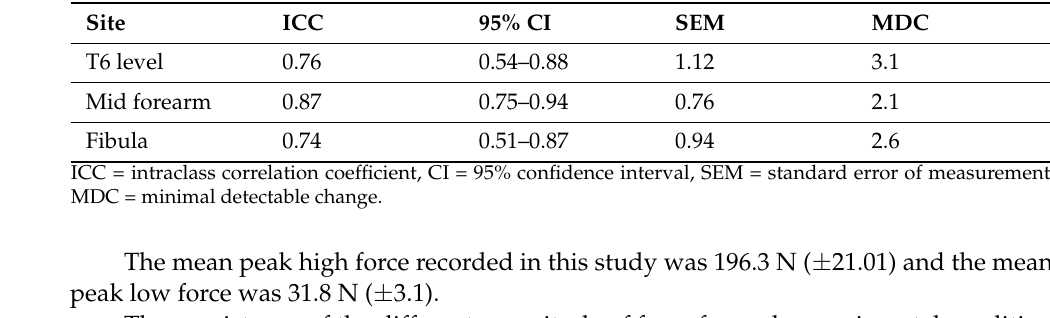
Table 3. Reliability of baseline measurements.